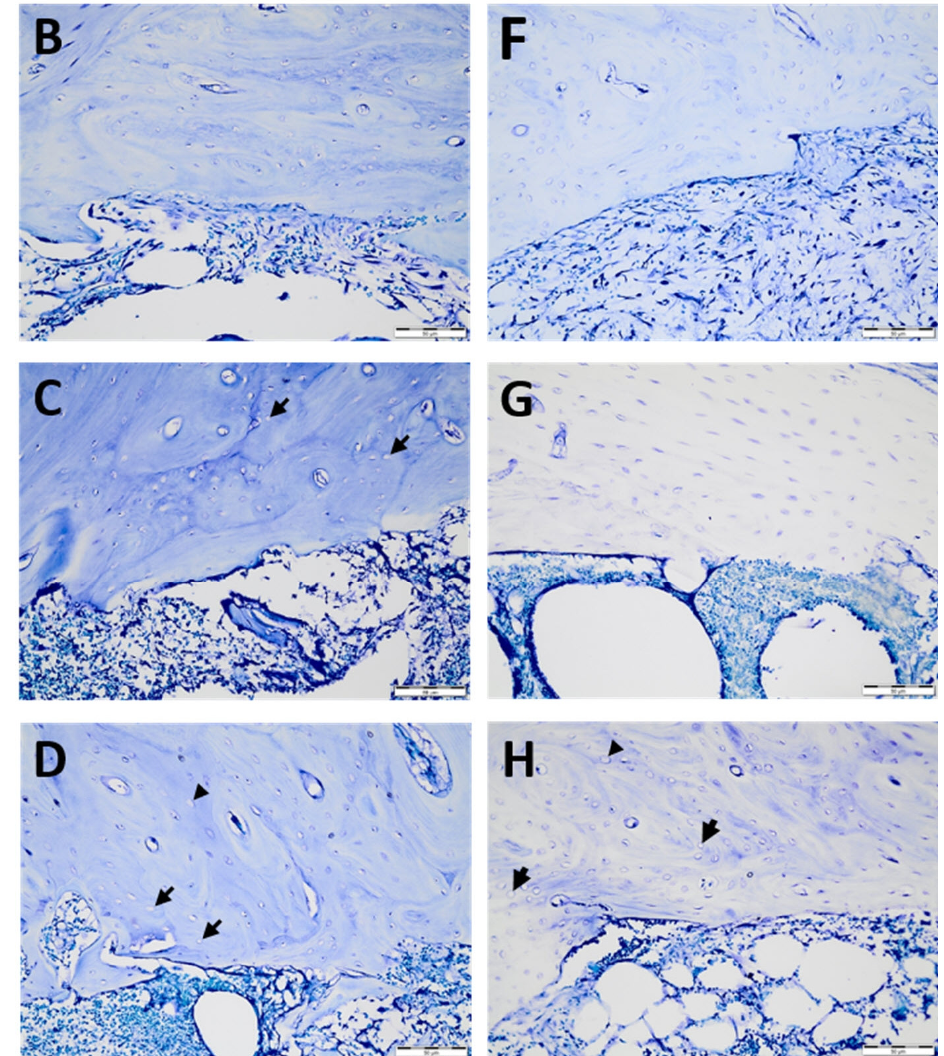
Figure 3. Histological sections of temperature-dependent bone tissue deterioration stained with toluidine blue: − 40 °C cryoprobe area ( A – D ) for the control ( A ), 1 min ( B ), 2 min ( C ), and 5 min ( D ) and − 80 °C cryoprobe area ( E – H ) for the control €, 1 min ( F ), 2 min ( G ), and 5 min ( H ). Empty lacunae (arrows) enlarged lacunae (arrowheads). Scale bar: 50 µm. High-resolution tif images of tibias that underwent − 40 and − 80 degrees cryotherapy are presented as Figure S1.tif and Figure S2.tif files, respectively.